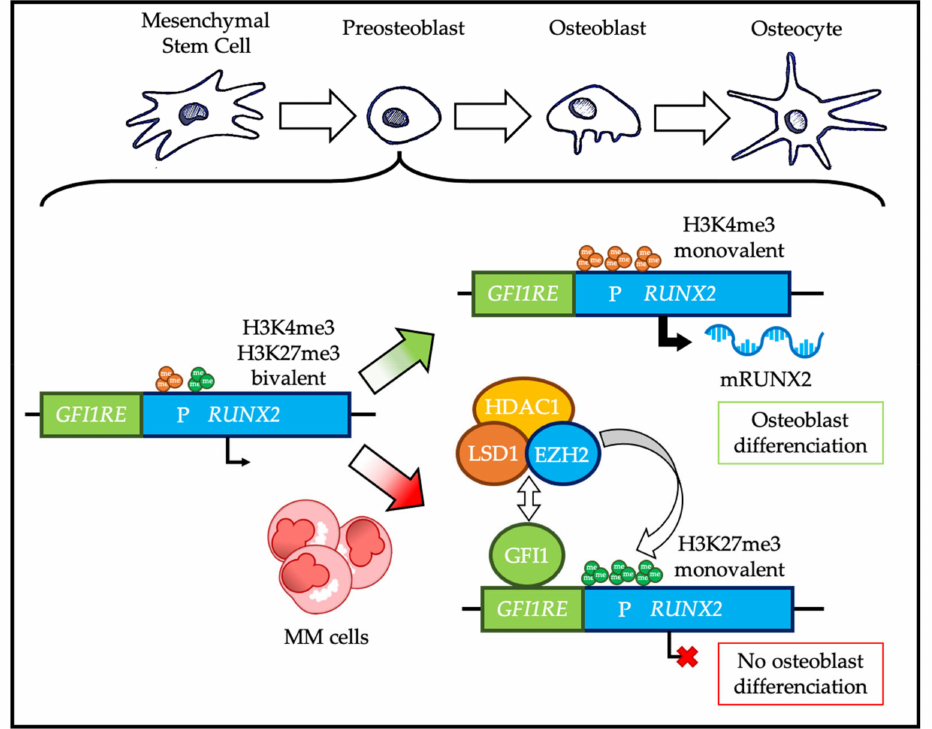
Figure 6. Role of EZH2 in multiple myeloma (MM) bone disease. Under physiological conditions, the RUNX2 gene promoter is found in a bivalent state in osteoblastic progenitors; the normal resolution of this bivalency is oriented towards a H3K4me3 monovalent state, which allows the transcription of RUNX2 and then osteoblastic di ff erentiation. However, in presence of MM cells, osteoblastic progenitors overexpress GFI1, which recruits EZH2, LSD1, and HDAC1 on RUNX2 promoter and induces a bivalent resolution oriented towards a H3K27me3 monovalent state and a transcriptional repression of RUNX2, resulting in an inhibition of osteoblastic di ff erentiation. P: promoter; GFI1RE: GRI1 responsive element; mRUNX2: RUNX2 mRNA. Green arrow represents normal physiology and red arrow represents deregulations in MM